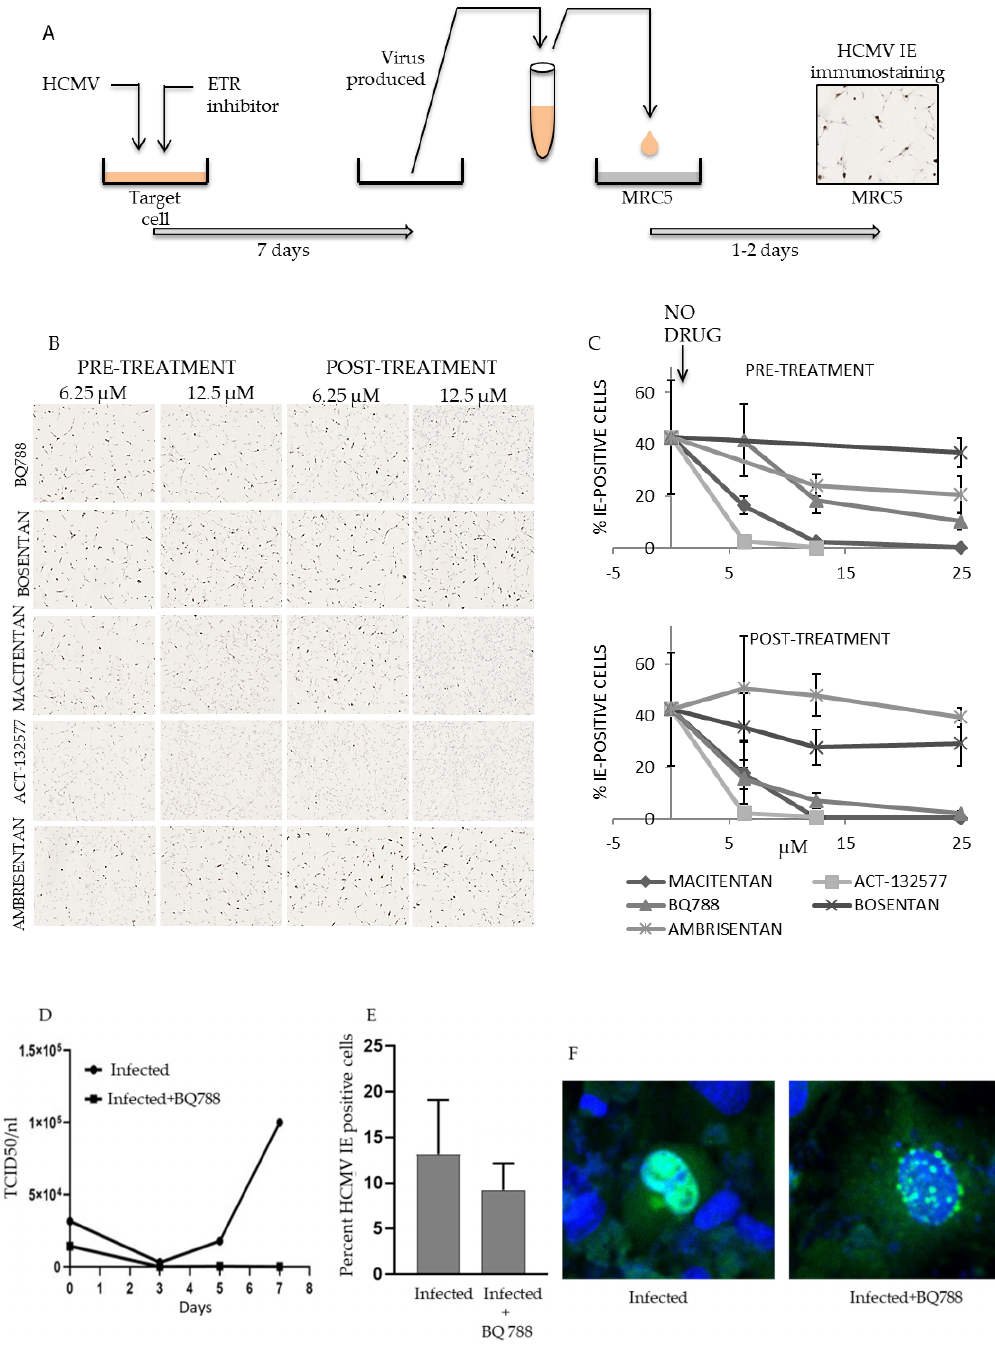
Figure 3. ETR antagonists prevent virus production. HUVECs were treated with ETR antagonists for 1 h before (pretreat- ment) or after (post-treatment) exposure to HCMV. ( A–C ) At seven days post infection, the virus-containing supernatant was harvested and used to infect MRC5 cells. ( A ) Schematic diagram of the experimental procedure. ( B ) Representative images of infected MRC5 fibroblasts 1 day after infection. The brown stain corresponds to IE immunoreactivity. ( C ) Percentage of IE-positive MRC5 cells after 1 day post infection after exposure to supernatant from 7-day infected HUVECs. The arrow indicates data points with no drug (0 µ M). ( D ) TCID50/mL was measured in MRC-5 cells. Cells were exposed for 5 days to either supernatants or HUVECs infected with VR1814 (MOI of 2) and treated or not with 100 µ M of BQ788 and were collected at 5 h after infection (0-dpi), 3-, 5- and 7-dpi. ( E ) Percentage of positive IE stained cells in HUVECs exposed to C17222 infected MRC-5 cells with ratio 1:50 ( p = 0.058). ( F ) Representative images of infected and infected and treated with BQ788 at 100 µ M with confocal microscopy ( × 20 magnification). The nuclei are stained with DAPI (blue) and an IE specific antibody (green). Values are mean ± SD of at least triplicate